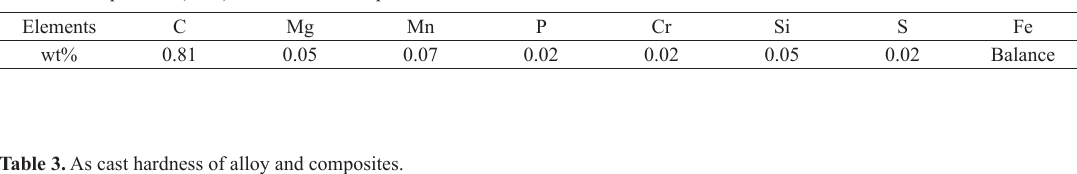
Table 3. As cast hardness of alloy and composites.